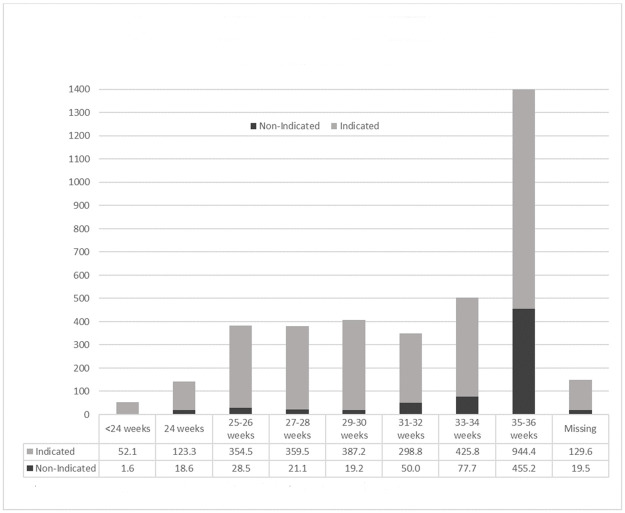
Distribution infants across gestational age and by MRI indication status.a values are weighted absolute numbers of indicated and non-indicated infants.